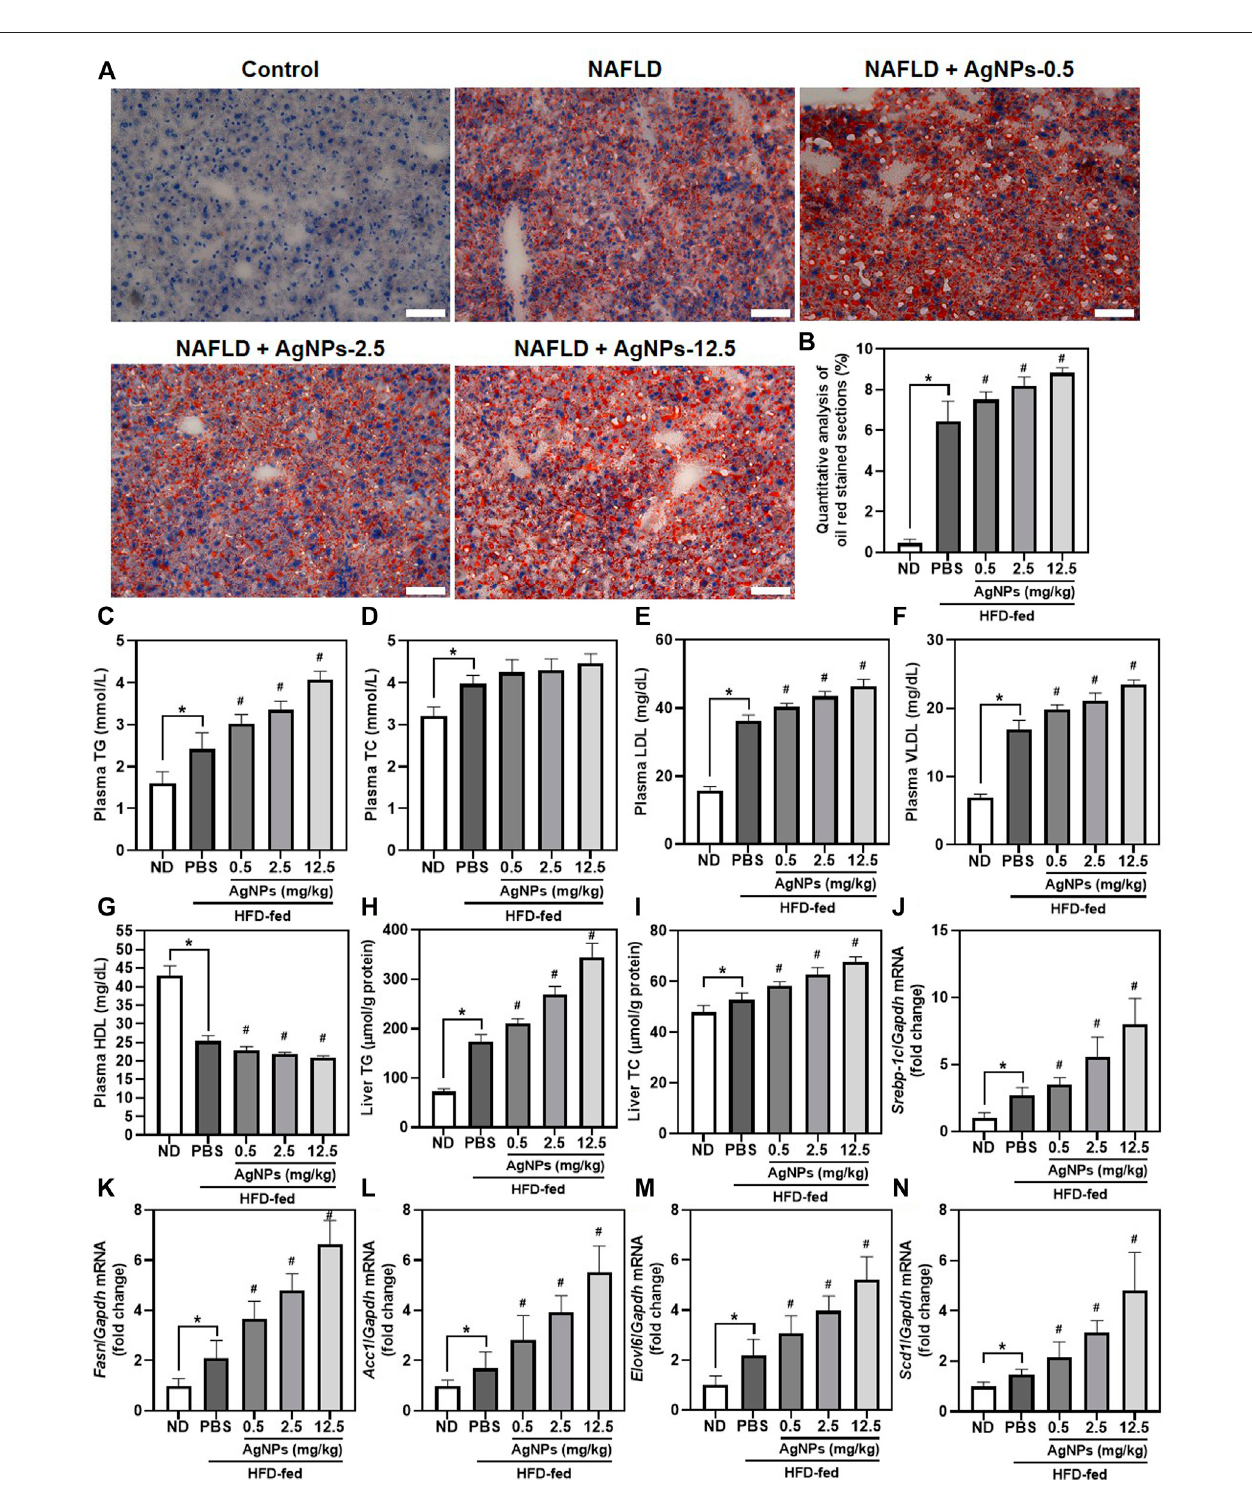
FIGURE 3 | AgNPs exacerbated HFD-induced hepatic steatosis in a manner involving altered expression of the genes for de novo lipogenesis (DNL) in mice. Representative images of ORO staining (A) and quantitative analysis (B) of the positive ORO-stained sections in the liver in ND-fed mice and HFD-fed mice treated with AgNPs. Scale bars, 50 μ m. (C) The level of plasma total triglyceride (TG). (D) The level of plasma total cholesterol (TC). (E) The level of plasma low-density lipoprotein (LDL). (F) The level of plasma high-density lipoprotein (HDL). (G) The level of plasma very low-density lipoprotein (VLDL). (H) The content of hepatic TG. (I) The contentofhepaticTC.Theexpressionofgenesrelatedtohepatic denovo lipogenesis,suchasSrebp-1c (J) anditstargetgenesincludingFasn (K) ,Acc1 (L) ,Elovl6 (M) , and Scd1 (N) . Gene expression was normalized to Gapdh. * p < 0.05 vs. ND-fed group; # p < 0.05 vs. HFD-treated group.